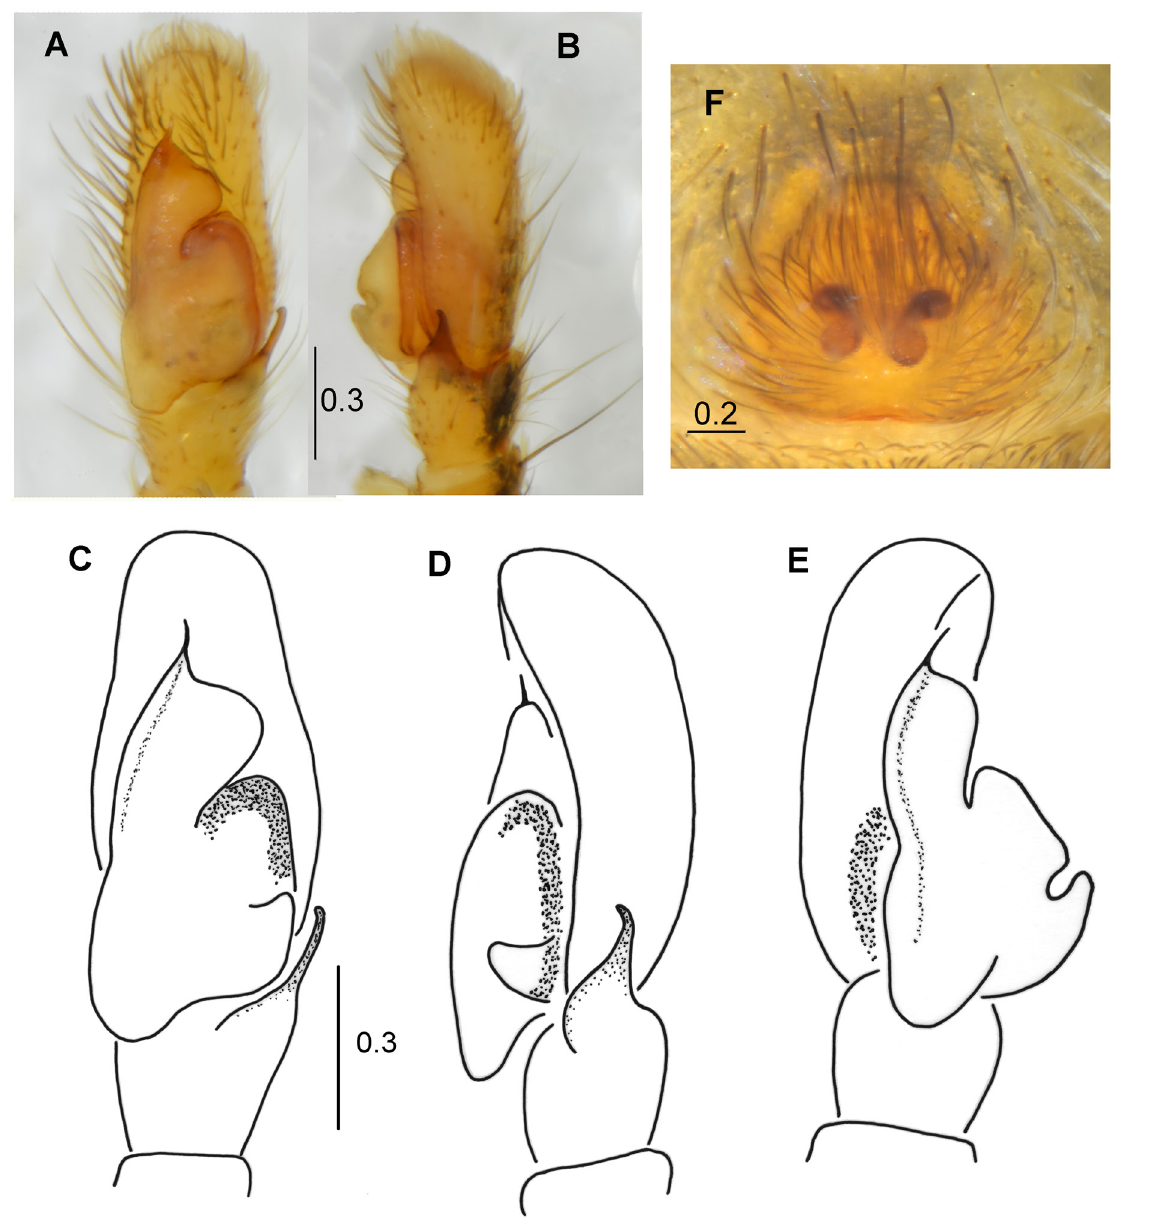
Fig. 37. Mexcala torquata Wesołowska, 2009, ♂♀ (MNHN). A, C . Palpal organ, ventral view. B, D . Palpal organ, retrolateral view. E . Palpal organ, ventroprolateral view. F .